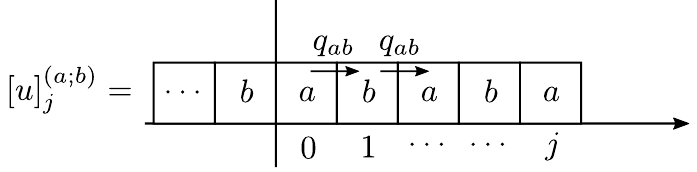
Figure 41. Subquiver and crystal shape of one-dimensional and two-dimensional crystal.